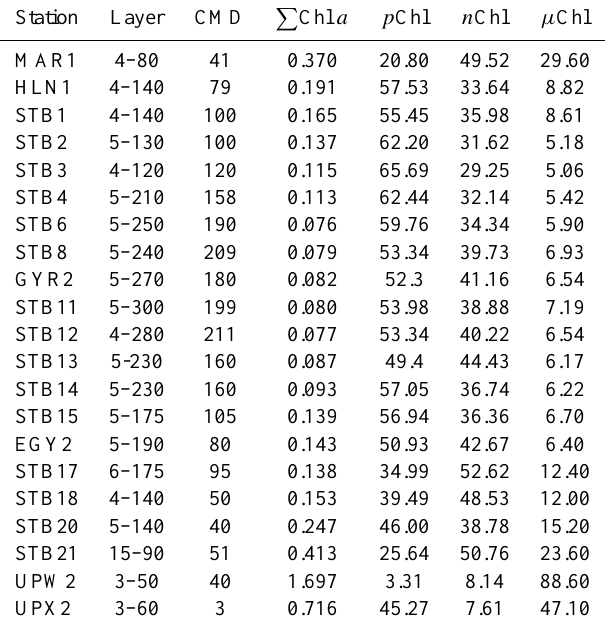
Table 3. Summary of phytoplankton pigment data. Layer denotes segment (m) of the water column sampled at 7-10 discrete depths (generally 9). CMD is the chlorophyll maximum depth (m) based on the chlorophyll vertical profile, P Chl a is the average chloro- phyll a concentration ( µ gl − 1 ) throughout the layer sampled. To- tal chlorophyll was partitioned into 3 size fractions (see methods); p Chl a , n Chl, µ chl are, respectively, estimated average pico-sized, nano-sized and micro-size chlorophyll a concentrations as % total chlorophyll a throughout the layer sampled. Phytoplankton samples were not taken for Station SE3.